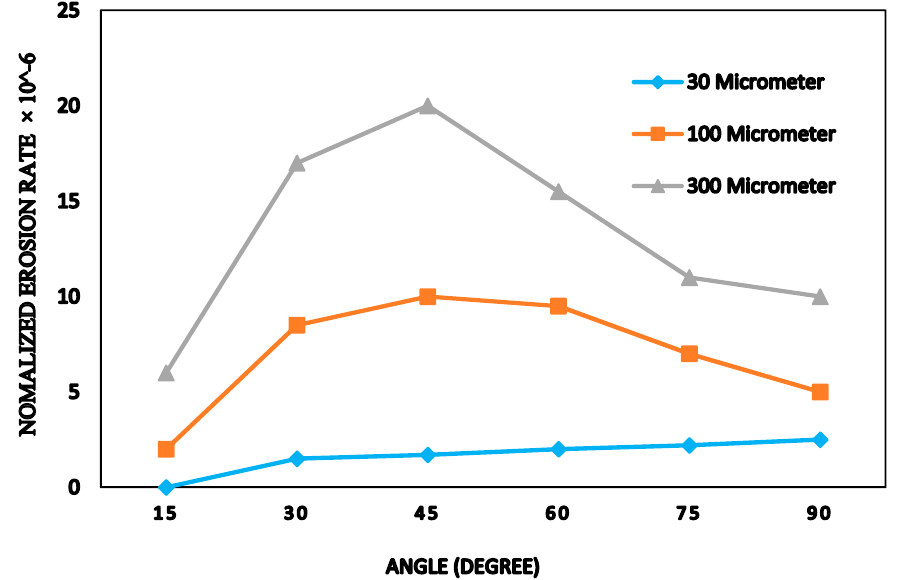
Figure 9. Erosion rate behavior for different particle sizes [20].